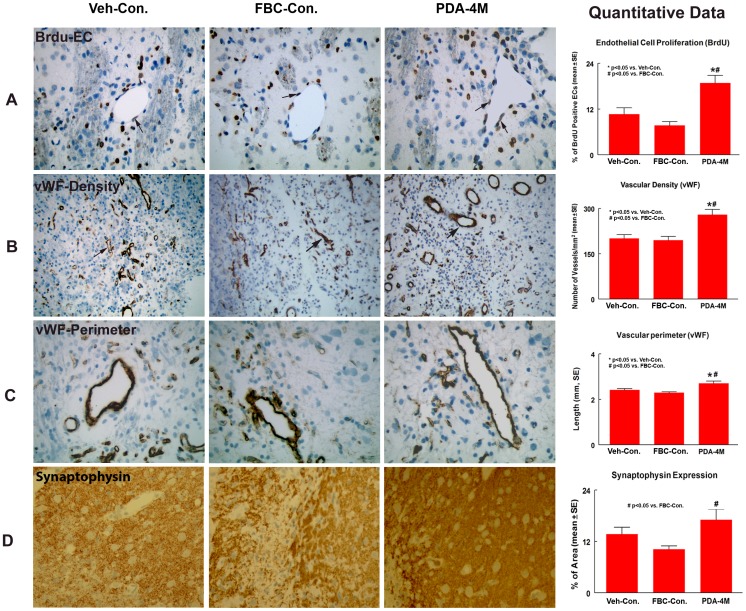
PDA-001 cell treatment promotes endothelial cell proliferation, vascular density and perimeter and increases synaptophysin expression in young adult rats after MCAo.Panels A–C show that PDA-001 treatment significantly increased endothelial cell proliferation (A), vascular density (B) and vascular perimeter (C) in the ischemic boundary zone (IBZ) in young adult rats. Panel D shows that PDA-001 treatment significantly increased synaptophysin expression in IBZ in young adult rats. Error bars represent standard error of the mean (mean±SE).